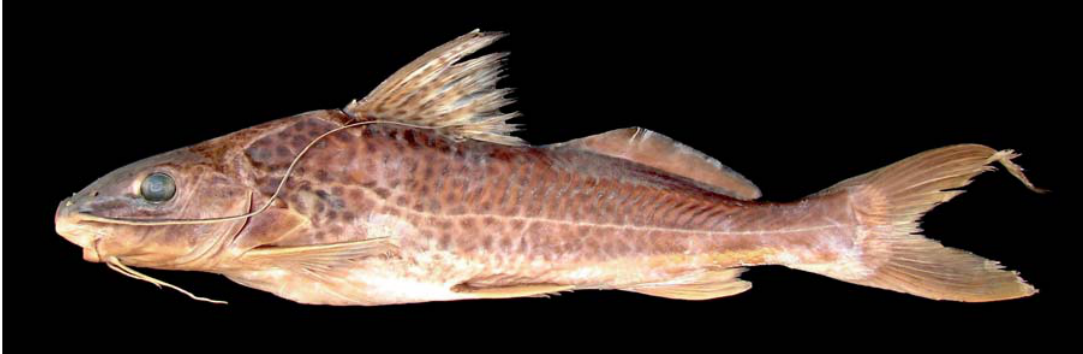
Fig. 2. Lateral view of Pimelodus ortmanni , MZUSP 50052, 265.0 mm SL, rio Iguaçu, downstream from Salto Osório dam, Quedas do